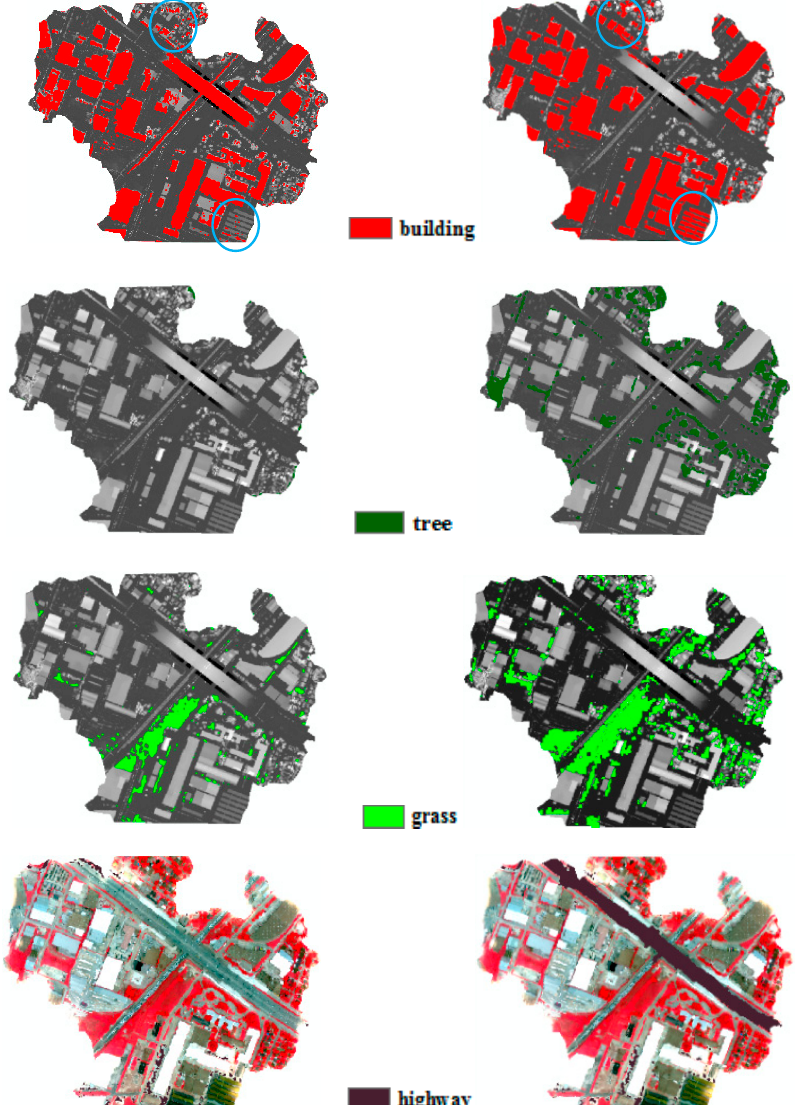
Figure 11. A comparison of the classified results in the shadow area between the traditional pixel-based SVM classifier (left) and the proposed object-based classification method (right).